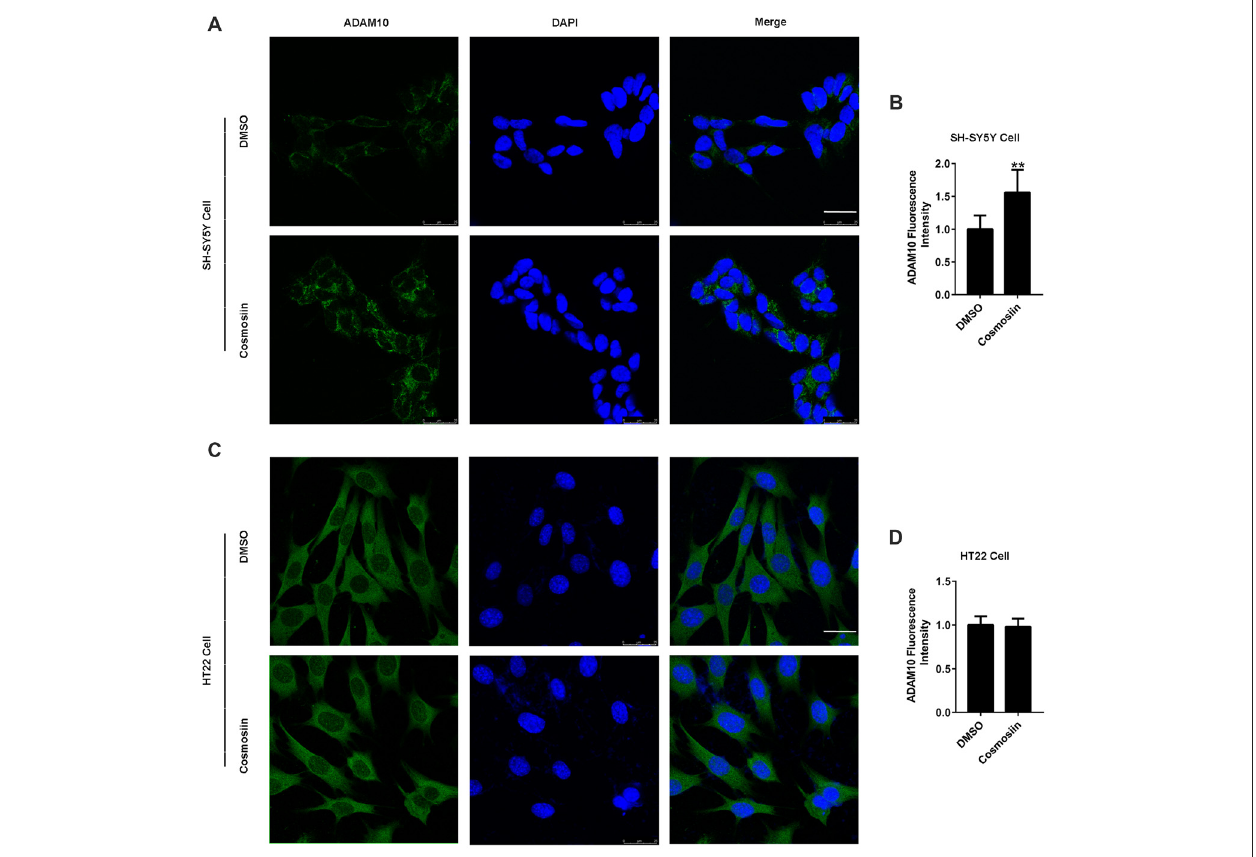
FIGURE 3 | Cosmosiin differentially affects ADAM10 immunofluorescent intensity in SH-SY5Y and HT22 cells. (A,B) Representative confocal microscopic images (A) and quantification (B) of immunofluorescence intensity of ADAM10 (green) in human SH-SY5Y cells in the absence (treated with DMSO only) and presence of cosmosiin (5 µ M for 36 h). (C,D) Representative confocal microscopic images (C) and quantification (D) of immunofluorescence intensity of ADAM10 (green) in murine HT22 cells in the absence (treated with DMSO only) and presence of cosmosiin (5 µ M for 36 h). DAPI (blue), a nuclear marker, served as internal control. Cosmosiin significantly increases immunofluorescence signals of ADAM10 in SH-SY5Y but not in HT22 cells. Scale bar, 25 µ m. ∗∗ P < 0.01 ( n =